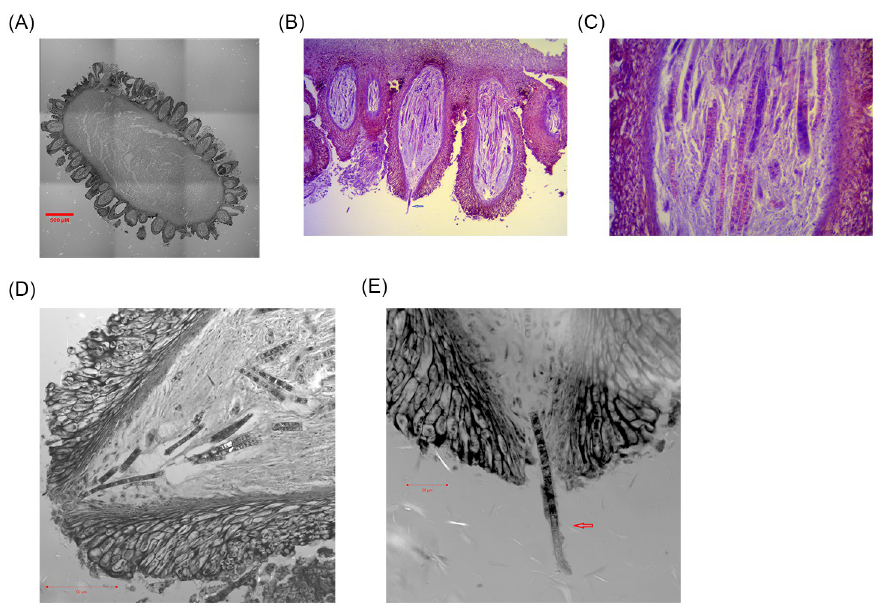
Fig 4. Microscopy images of the SFP, ascocarps and ascospores of C . sinensis . Fig 4A is a confocal image of a transverse section of the SFP (bar, 500 μ m). Fig 4B is an optical microscopic image (10x) of several C . sinensis ascocarps stained with hematoxylin-eosin. Fig 4C is a close-up optical image (40x) of an ascocarp stained with hematoxylin-eosin. Fig 4D and 4E are close-up confocal images showing ascospores gathering toward the opening of the perithecium (Fig 4D; bar, 50 μ m) and a semiejected ascospore hanging out of the opening of the perithecium (Fig 4E; bar, 20 μ m). Arrows in Fig 4B and 4E indicate semiejected ascospores.